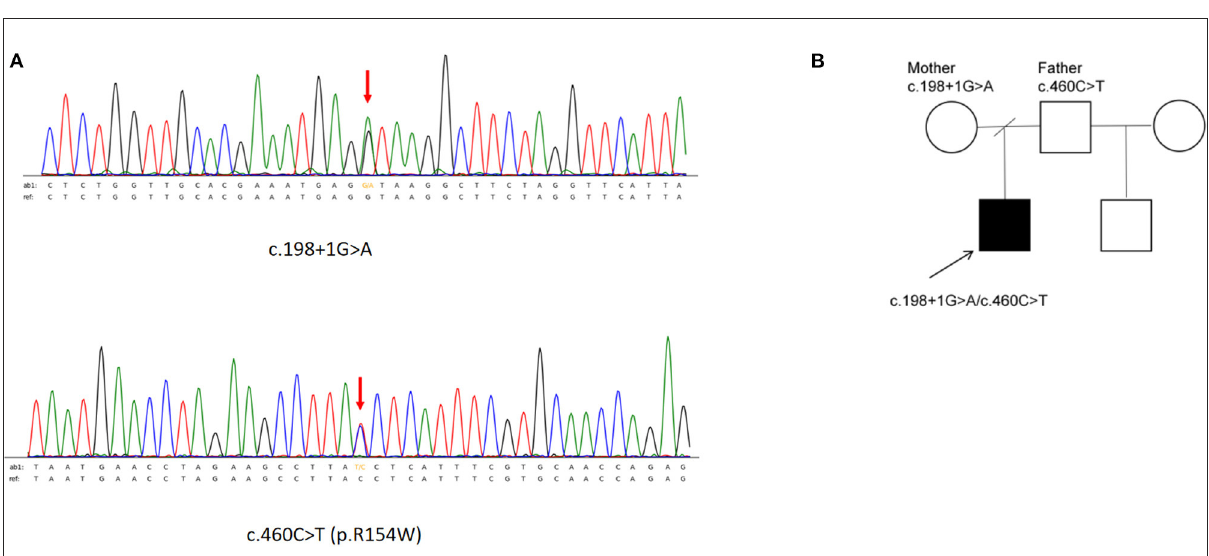
keto-type ceramides in the lesion areas. The formation of keto-type ceramides may be a bypass by ceramide synthases due to the limited function of the mutated KDSR enzyme in the metabolic pathway. Bypass products of keto-type ceramides are a possible cause of skin lesions.